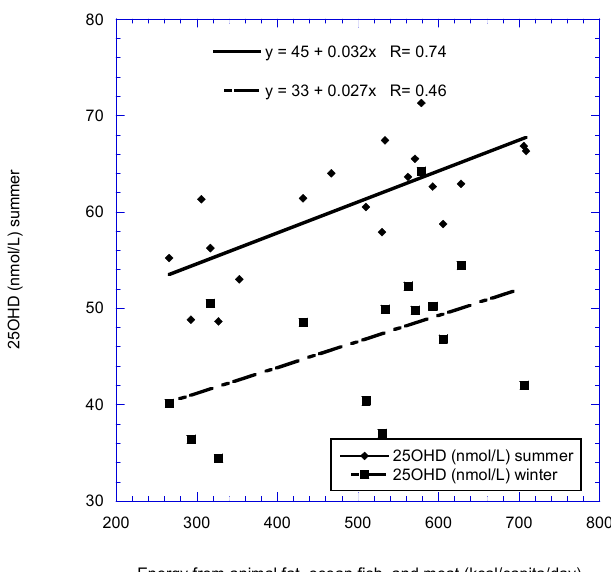
Figure 3. Plot of 25(OH)D concentration vs. dietary supply of ocean fish for the European postmenopausal women’s study [22].